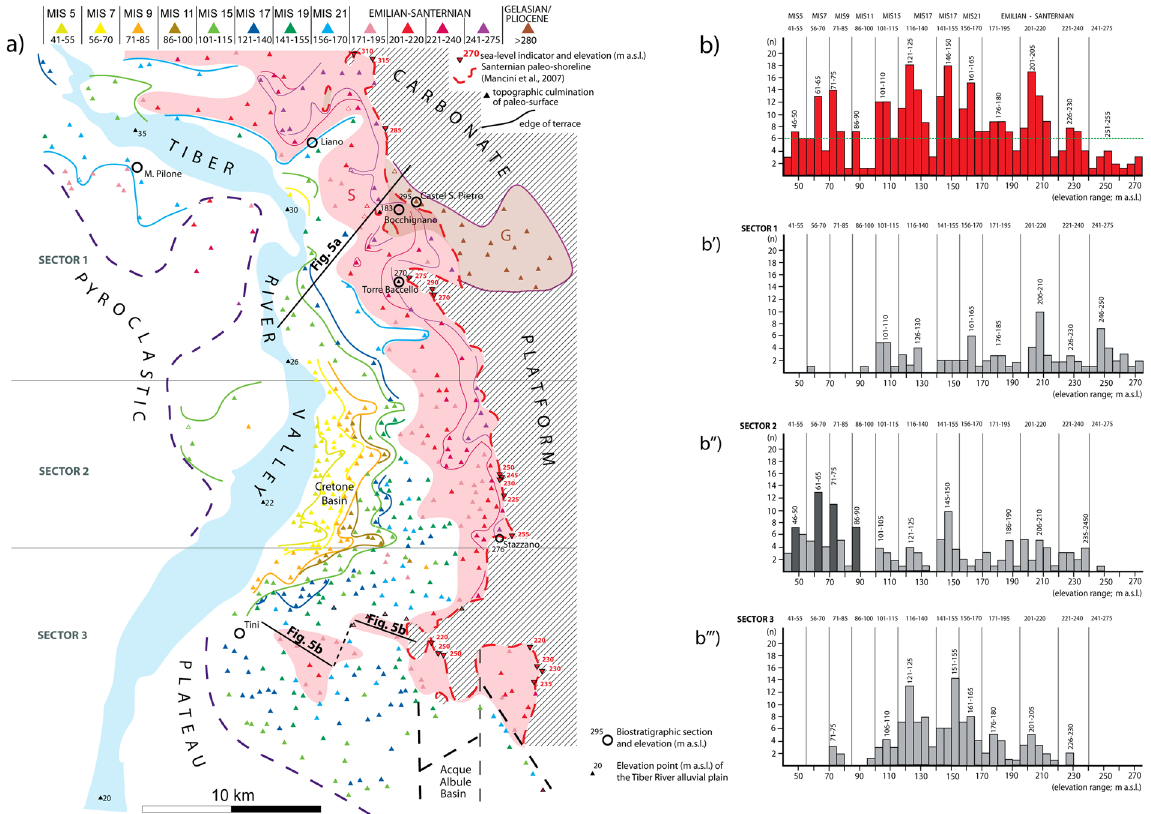
Figure 4. Geomorpholoic map and statistics. Map hand drawn with Adobe© Illustrator CS3 13.0.0 graphic program. ( a ) Geomorphologic map of the Tyrrhenian Sea margin of Latium in the area adjacent to the paleo- shoreline indicators (red triangles with downward vertex) of the Santernian coastline (red dashed line 10 ). A series of terraced surfaces is reconstructed following criteria established in ref. 12 and described in the text, from a dataset of topographic culminations (colored triangles with upward vertex); the colored lines are the inner margin of terrace. The red shaded area represents the oldest paleo-surface corresponding to the top of the continental deposits of late Santernian-Emilian age. ( b ) Histograms reporting distribution and peaks of concentration for the topographic culminations, for three different geographic sectors ( b ′ – b ″ – b ′′′ ) and for the total area ( b ). A series of classes of elevation, identifying the same number of paleo-surfaces are recognized and correlated with the sea-level highstands of marine isotopic stages (MISs), following criteria described in the text. Location of the investigated paleontological sites, the sedimentary sections and the two cross-section of Fig. 5 is